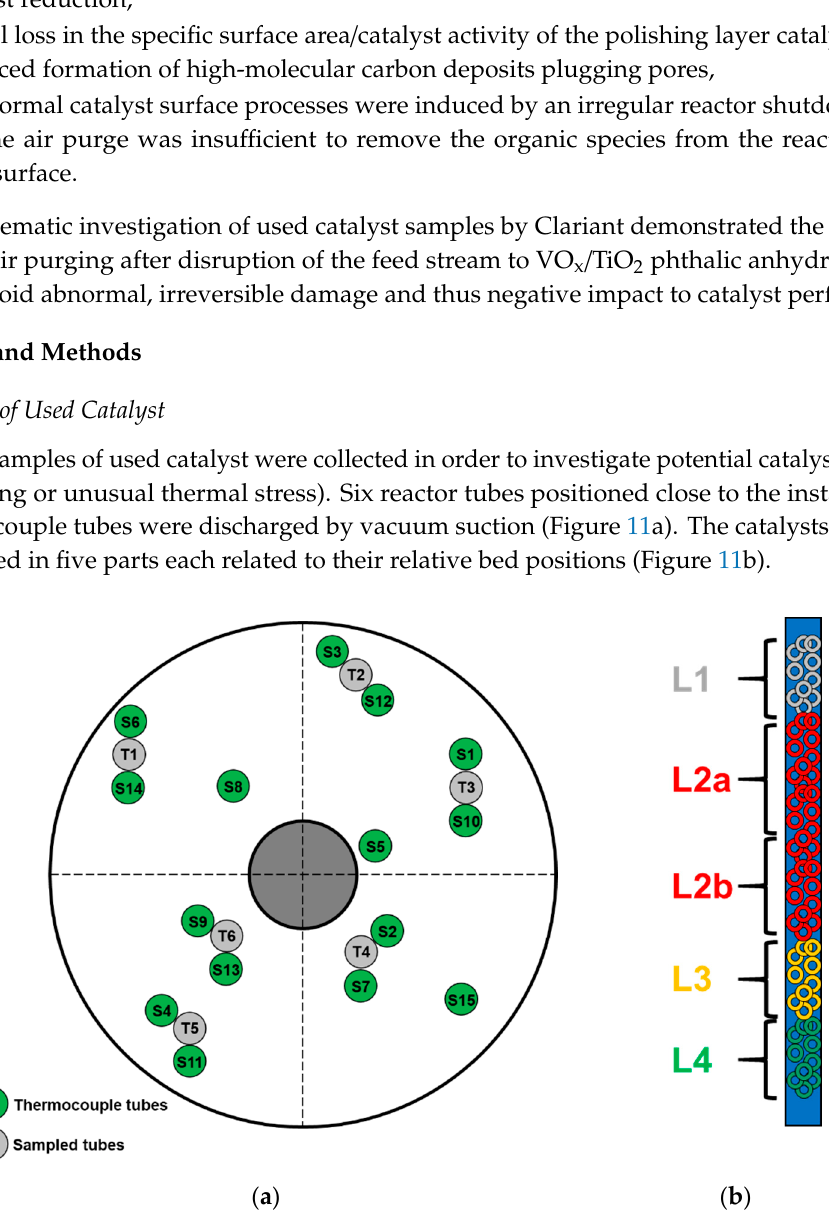
Figure 11. ( a ) Tube sheet location of the sampled tubes (T1–T6) neighboring the thermocouple tubes (S1–S15); ( b ) scheme of the five different samples taken along the catalyst